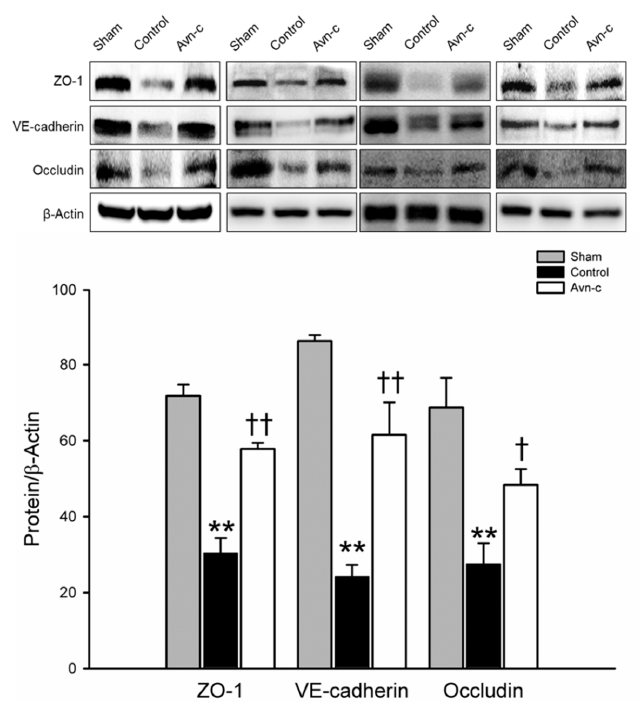
Figure 2. Western blot analysis for the expression of ZO-1, VE-cadherin and Occludin. The quantification of ZO-1, VE-cadherin and occludin protein expression. Data shown are mean ± SEM (data from 12 mice, n = 4). ** p < 0.01 vs. Sham group, and † p < 0.05, †† p vs. Control group.